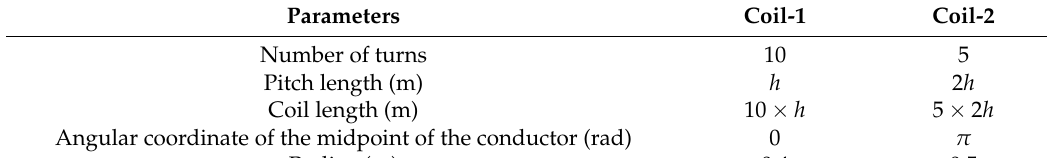
M ) of coils with equal radius. 12